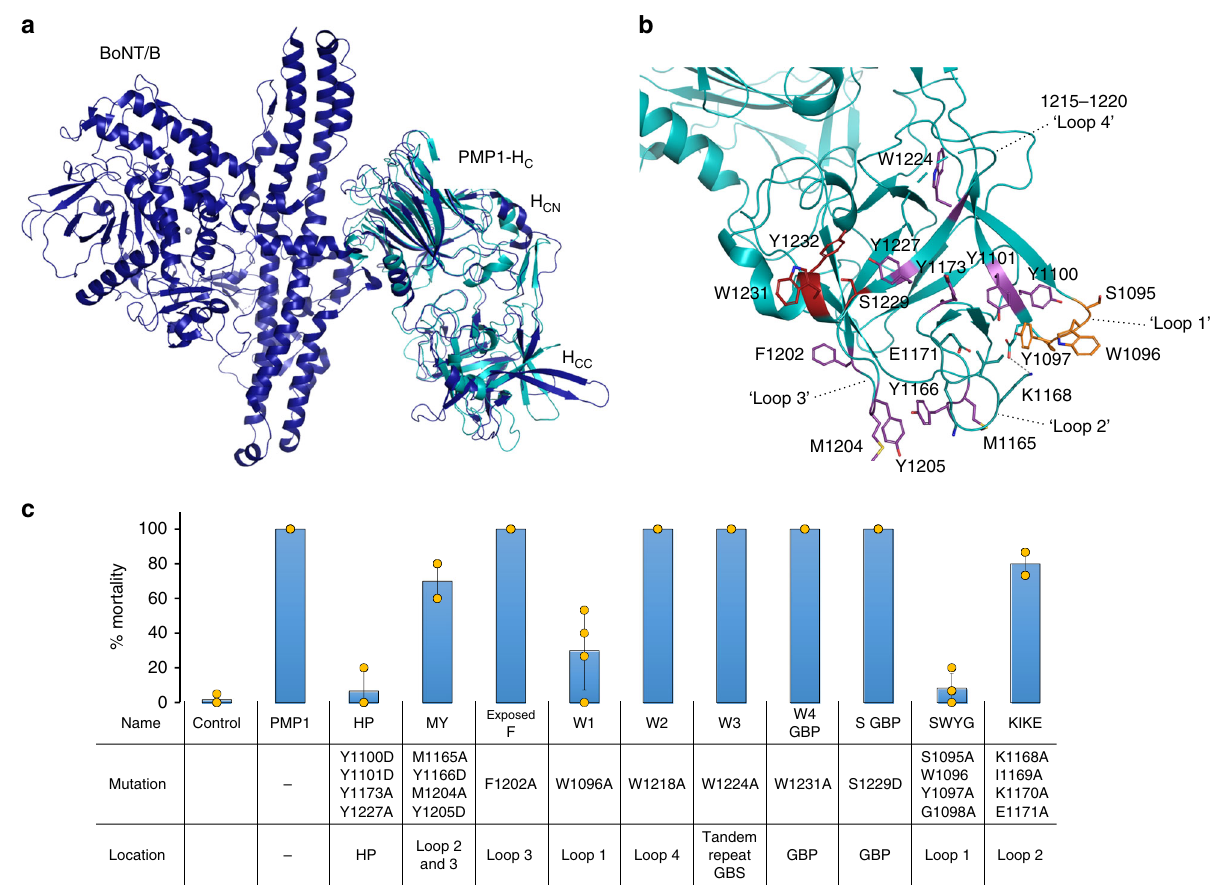
Fig. 4 Difference in the H CC domain of paraclostridial mosquitocidal protein 1 (PMP1) contributes to its selective toxicity. a Superimposition of the PMP1 H C crystal structure (cyan) with the full-length botulinum neurotoxin (BoNT)/B (blue, PDB 1EPW). The domains are labeled as LC (catalytic light chain), H N (translocation domain), and the H C (binding domain) with its two subdomains (H CN and H CC ). b Crystal structure of PMP1 H C. The aromatic residues exposed on PMP1 H CC surface, the mutations tested for toxicity (purple sticks), the loop 1 SWYG motif (orange sticks), and the conserved ganglioside- binding motif (red sticks) are labeled. The E1099-K1168 salt bridge is indicated as a dashed line. c Toxicity of PMP1 H CC mutants to A. aegypti 4th instar larvae by injection ( t test, p value ≤ 0.05). Error bars represent ± s.d. of at least three replicates. Source data are provided as a Source Data fi